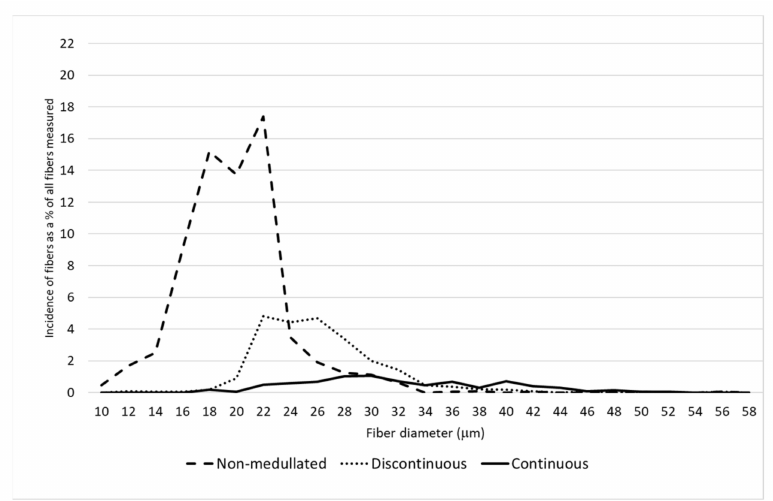
Figure 1. The distribution of each fiber category for